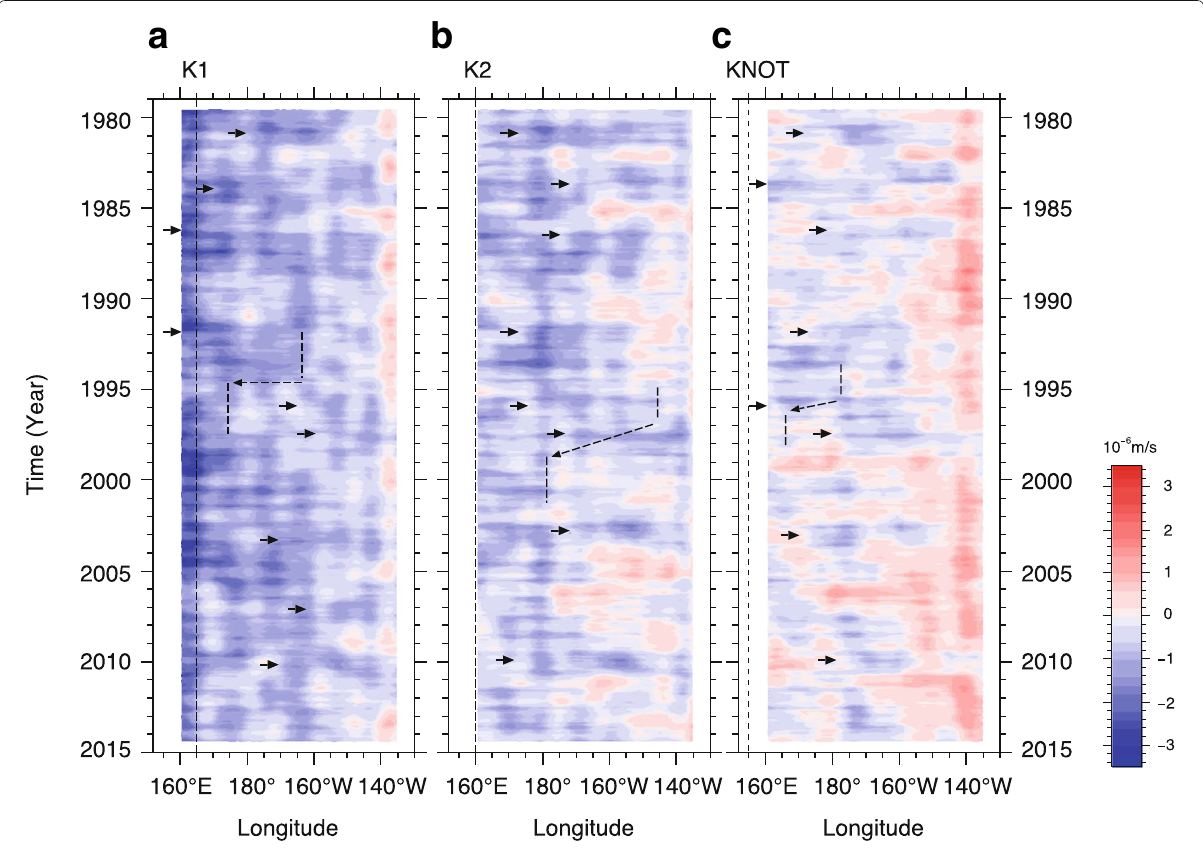
Fig. 10 a – c Same as Fig. 9 but for inverted Ekman vertical velocity, − w E , in 10 − 6 ms − 1 based on the NCEP/NCAR wind stress data from 1979 to 2014. Negative value indicates upward velocity, i.e., Ekman suction. Arrows show El Niño-related enhancements in Ekman suction. Vertical dashed lines and connecting arrows denote westernmost longitudes of significantly negative w E and their westward migrations in the 1990s,